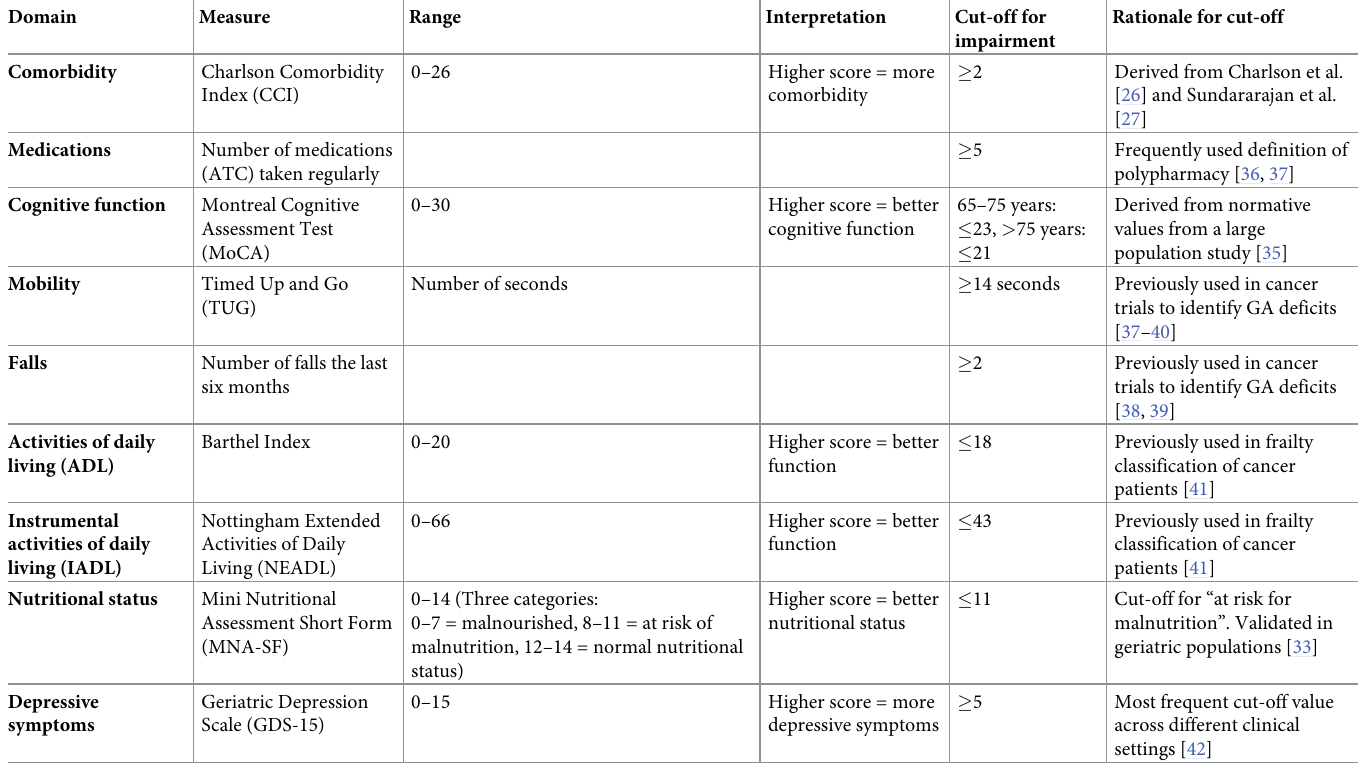
Table 1. Geriatric assessment: Domains, measures, and cut-off values for